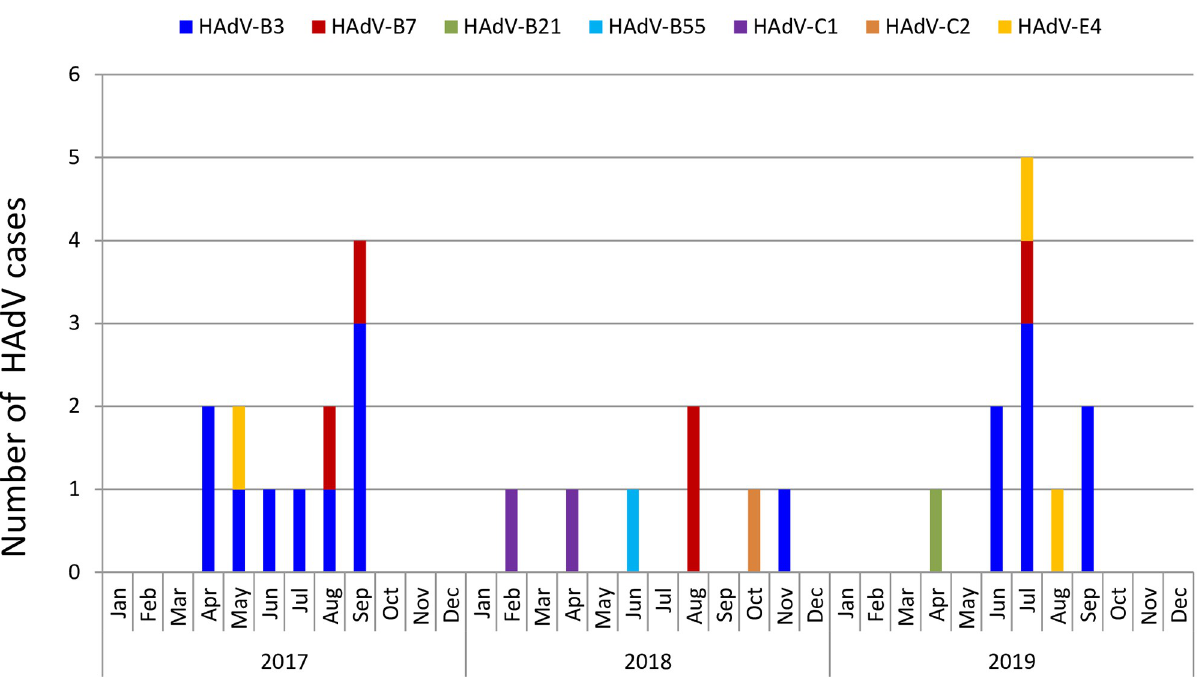
Fig 3. Distribution of HAdV genotypes detected according to